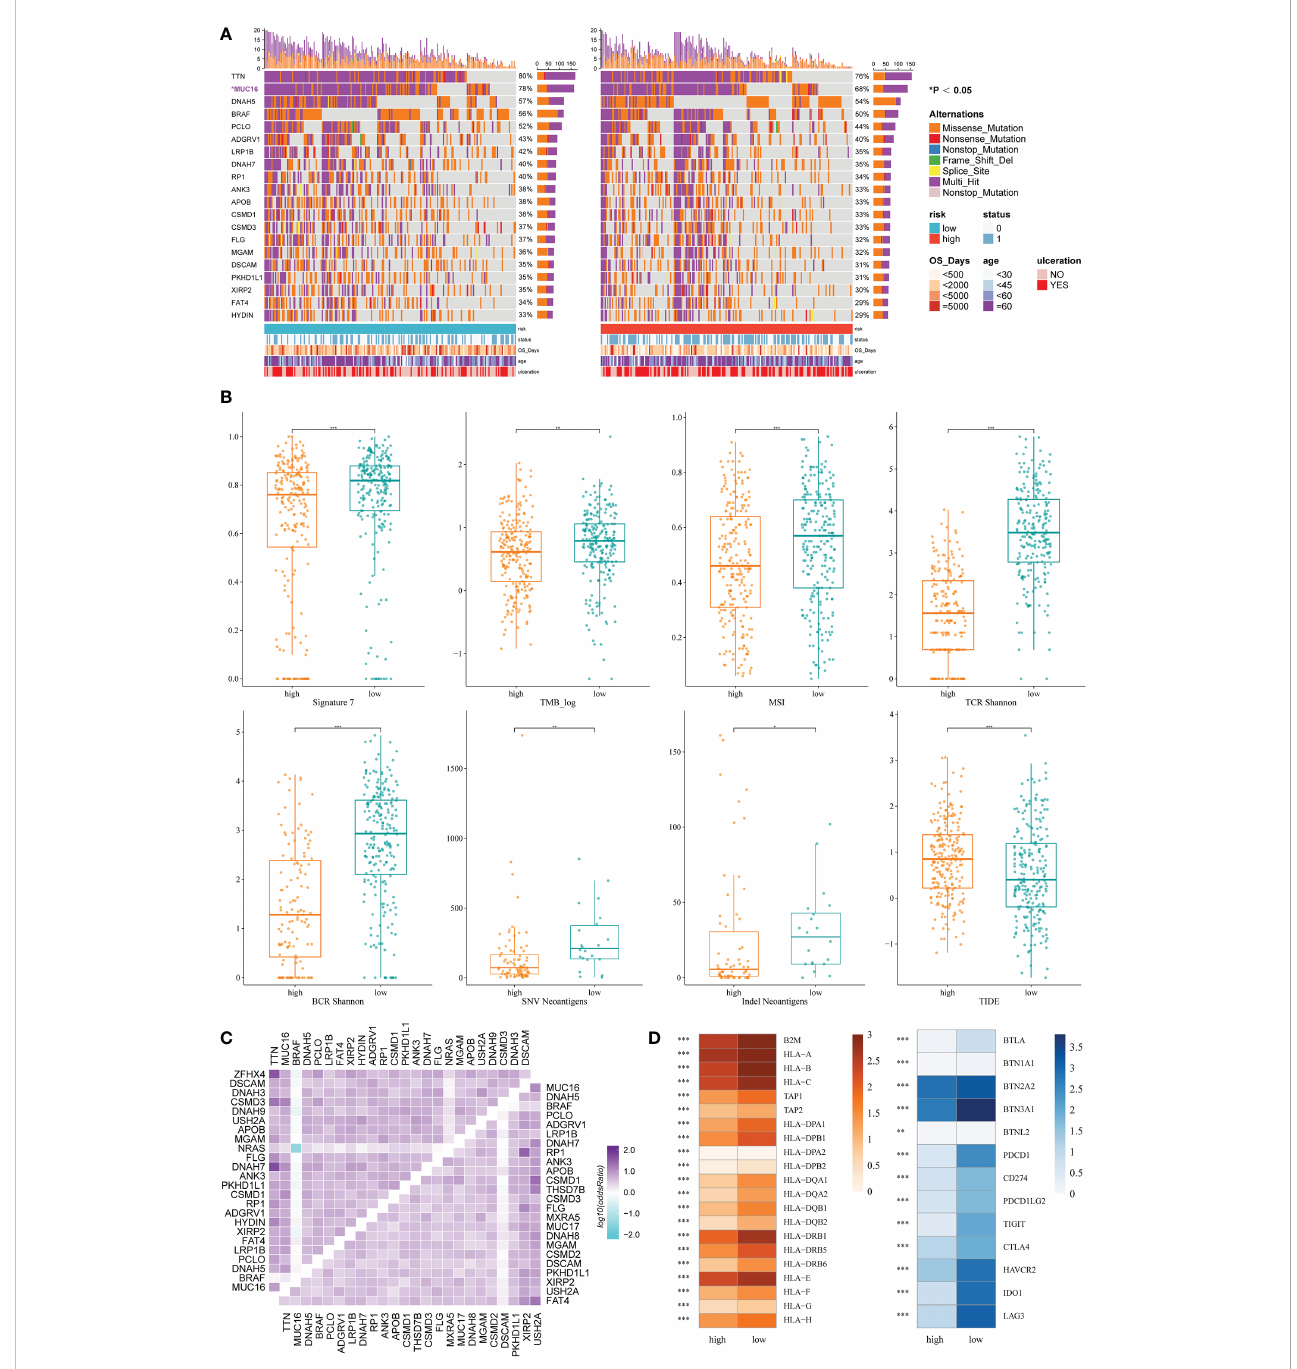
FIGURE 5 Genomic features and immunologic changes of the high- and low-score groups. (A) Mutation of top 20 most frequently altered genes in melanoma patients with high and low IRRS. (B) Cosmic mutation signature 7, tumor mutation burden, microsatellite instability, neoantigens, and TIDE score in the high- and low-score groups. (C) Heatmap depicting the co-occurrence or exclusivity of the top 25 most mutated genes in the high IRRS group (left upper corner) and the low IRRS group (lower right corner). (D) Association between HLA and immune checkpoint molecules and the IRRS. *P<0.05 **P<0.01